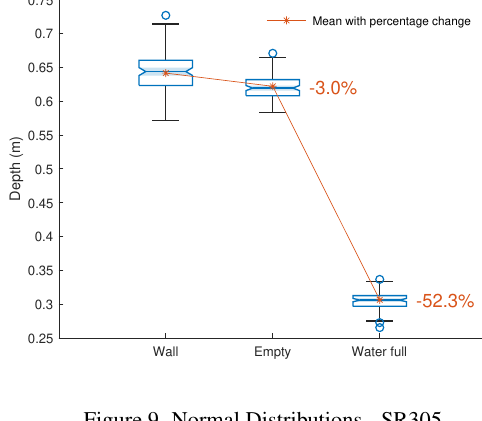
Figure 9. Normal Distributions - SR305